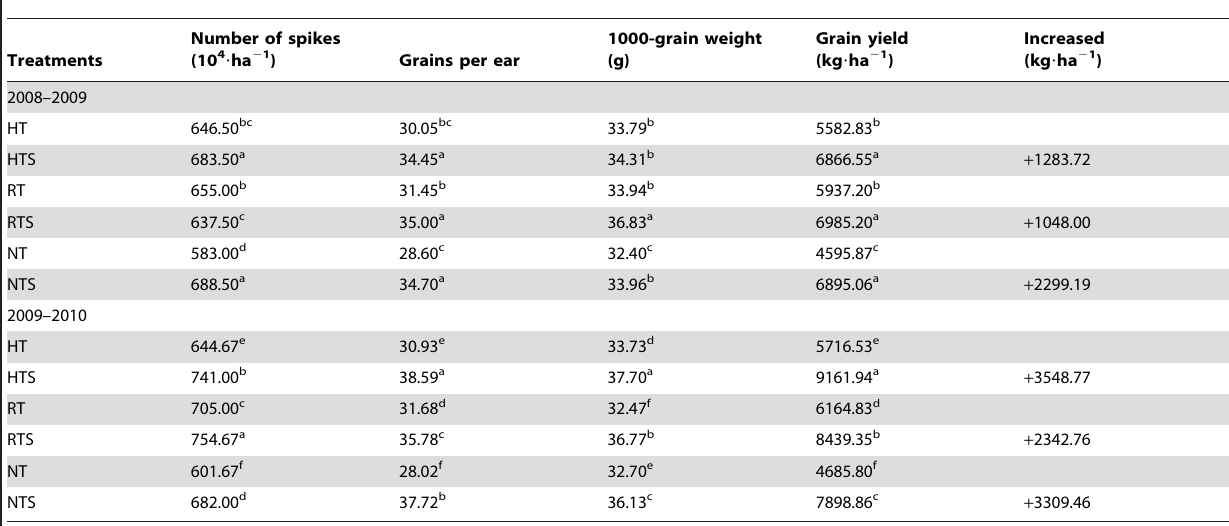
Table 4. The wheat yield variations of HT, RT and NT after subsoiling from 2008–2010.